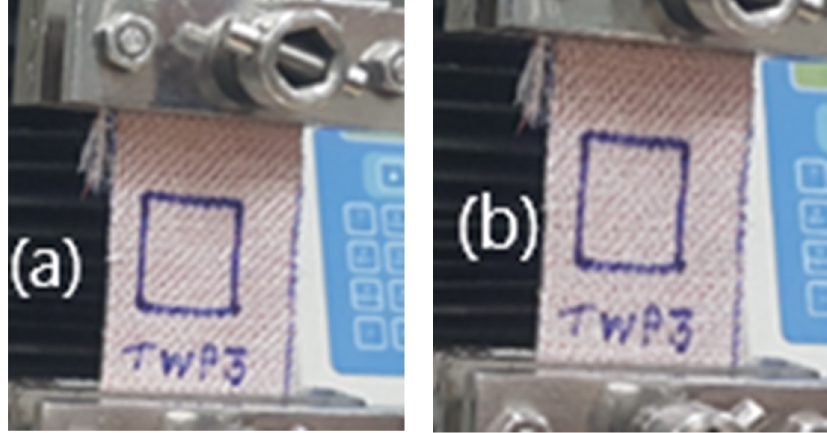
Figure 7. Changes in the dimensions of the unit square cell ( a ) initial relaxed position, ( b ) stretched position.